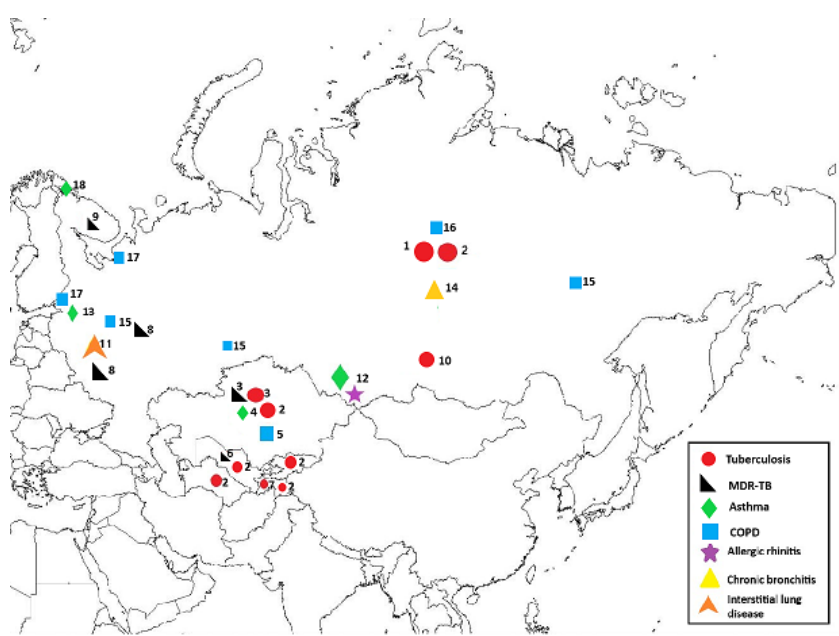
Figure 2. Overview of geographic locations of respiratory disease prevalence studies in Russia and Central Asia. (1) Russia (nationwide) [12]; (2) Kazakhstan, Kyrgyzstan, Tajikistan, Turkmenistan, Uzbekistan, Russia (nationwide) [13]; (3) Kazakhstan (nationwide) [14]; (4) Almaty, Kazakhstan [26]; (5) Almaty, Kazakhstan [23]; (6) Uzbekistan [16]; (7) Sughd province, Tajikistan [15]; (8) Vladimir region, Russia [17]; (9) Murmansk region, Russia [18]; (10) Krasnoyarsk region, Russia [19]; (11) Moscow, Russia [29]; (12) Altay region, Russia [28]; (13) St. Petersburg, Russia [25]; (14) Russia [20]; (15) Vologda, Chelyabinsk, Yakutsk, Russia [21]; (16) Russia [22]; (17) St. Petersburg and Arkhangelsk, Russia [24]; and (18) Nikel, Russia [27].